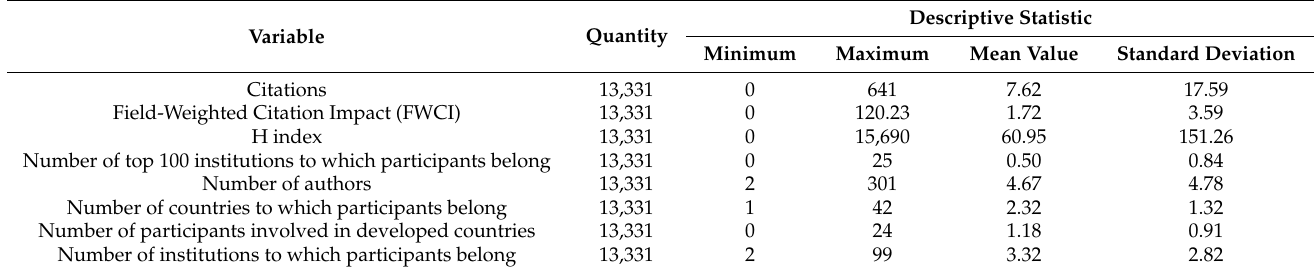
Table 2. Descriptive analysis of